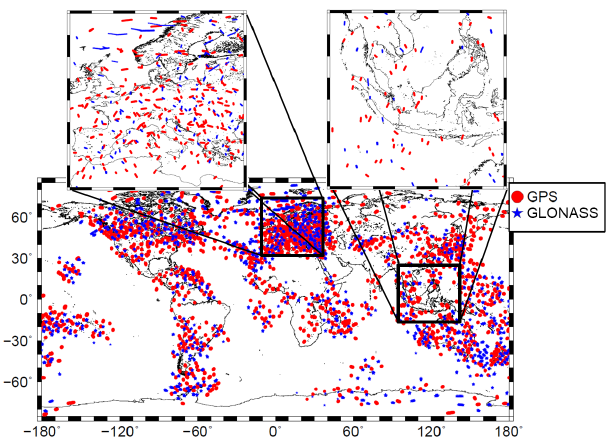
Figure 1. Global distribution of the IPPs from GPS (red dots) and GLONASS (blue stars) measurements for 6 September 2017 col- lected within a 10min interval between 12:55 and 13:05UT. The regional maps at the top are “zoom-ins” of Europe and